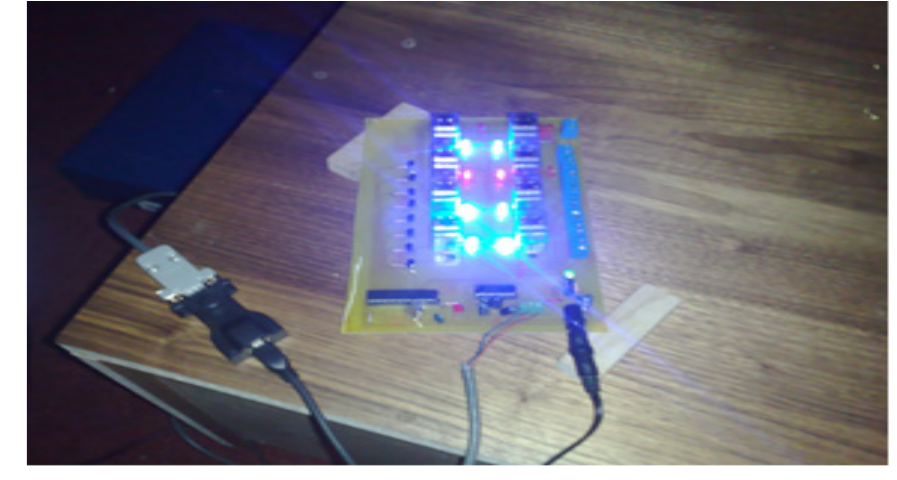
Fig. 12. All relays are